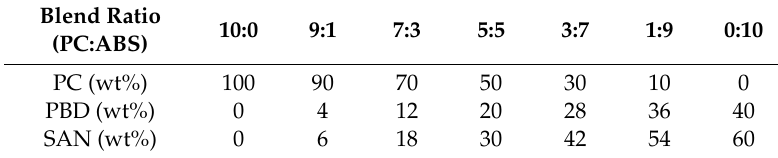
Table 1. Blend composition of polycarbonate / acrylonitrile-butadiene-styrene (PC /